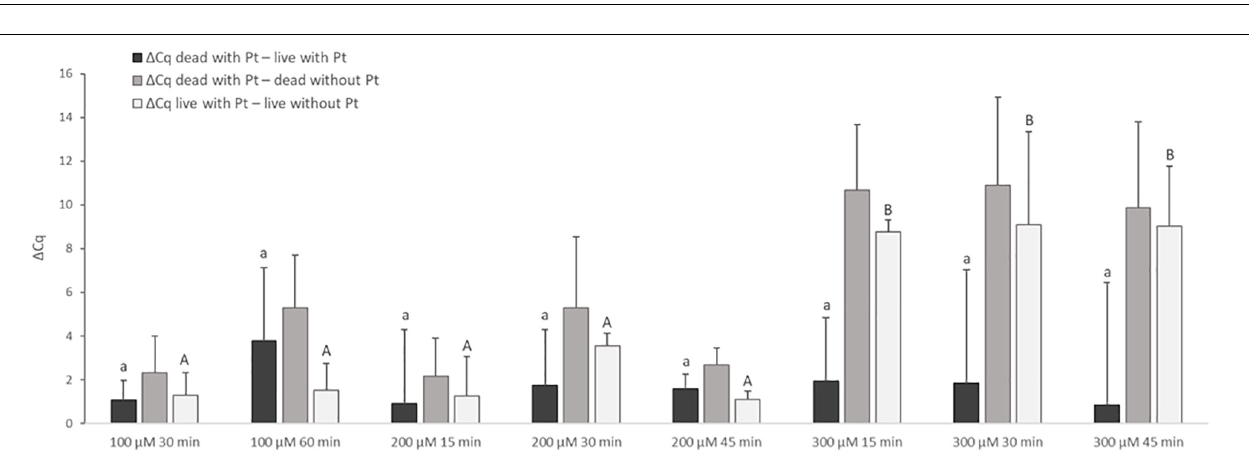
FIGURE 2 | Direct effect of Pt compound solutions at various concentrations on amplification of MAP DNA diluted with TE buffer or ultrapure water. The (cid:49) Cq values express the mean difference of individual Cq values of Pt-treated and mean Cq value of untreated control samples calculated from four replicates (biological and technical). The significance of differences between (cid:49) Cq was calculated by two-way ANOVA with factors of concentration and dilution medium and Tukey’s HSD test. The same letters indicate statistically insignificant differences ( P > 0.05) between (cid:49) Cq values, while different letters indicate significant differences ( P < 0.05). Error bars represent standard deviations calculated from four replicates. The bar above value of 18 in (cid:49) Cq on the y -axis signifies that no amplification occurred.